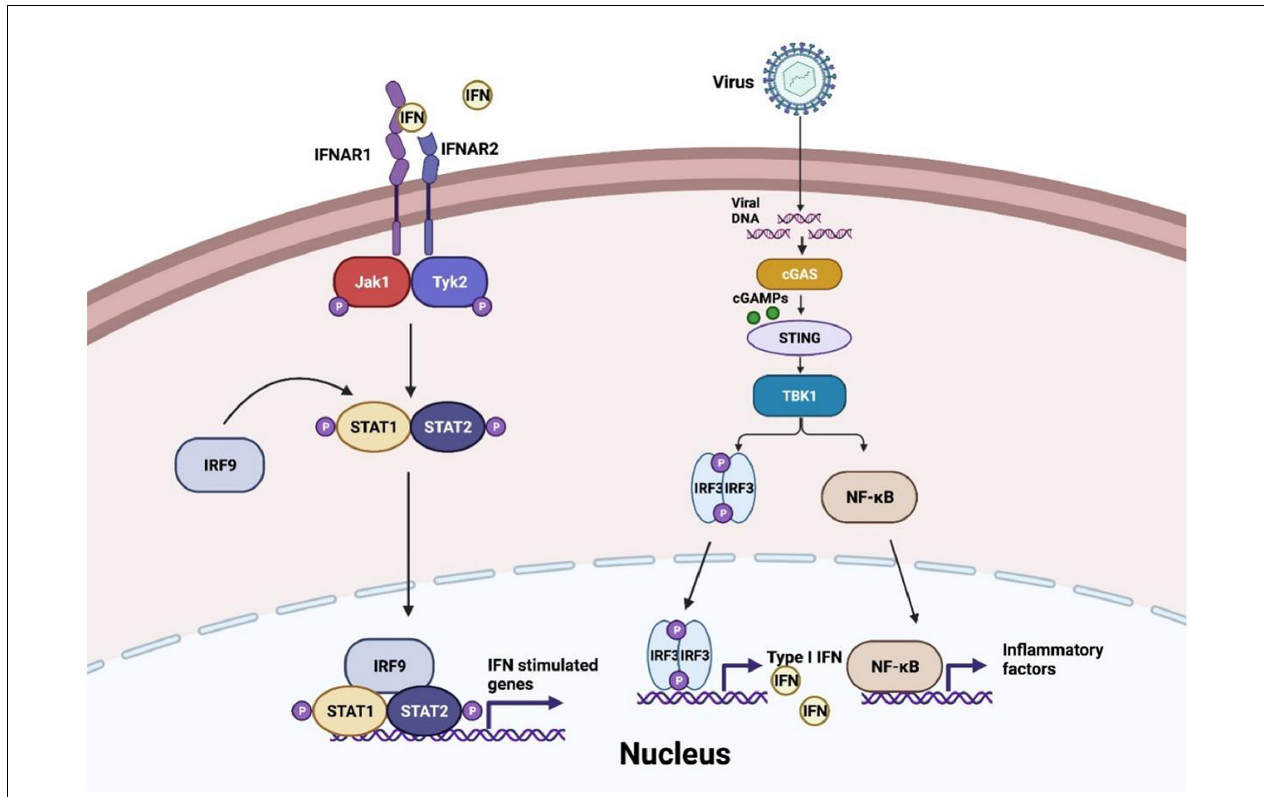
FIGURE 1 | cGAS-STING pathway in virus invasion. After virus infection, cyclic GMP-AMP synthase (cGAS) senses the viral DNA to synthesize cyclic GMP-AMPs (cGMPs) and activate stimulator of interferon genes (STING) to recruit TANK-binding kinase 1 (TBK1) and I κ B kinase (IKK), and then interferon regulatory factor 3 (IRF3) and nuclear factor- κ B (NF- κ B) are induced to translocate into the nucleus and generate the production of IFN-I- β and inflammatory factors. IFN-I- β conducts Janus kinase signal transducer and activator of transcription (JAK-STAT) pathway activation and initiates interferon-stimulated genes